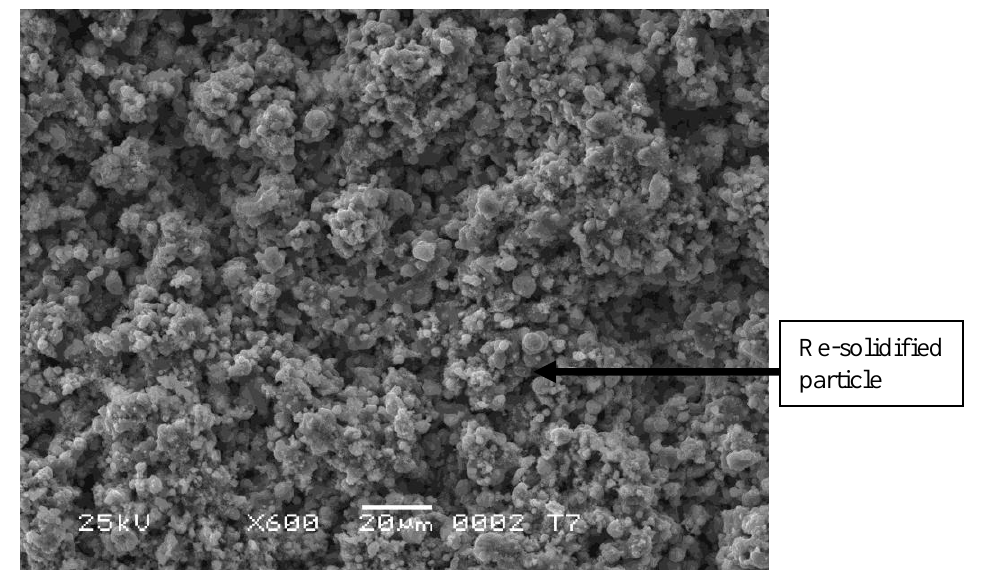
Figure 1. SEM (secondary electrons) micrograph of titanium oxide (TiO suspension plasma sprayed using an external atomizing